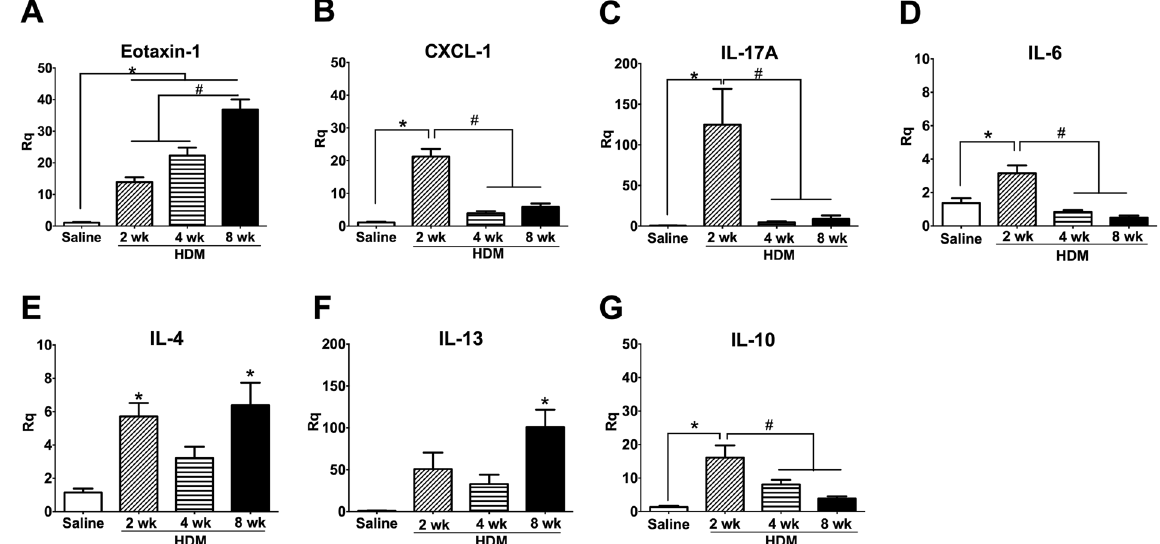
Figure 6. The 3 HDM models exhibit different patterns of inflammatory mediator expression. ( A ) Eotaxin-1 expression increased with increasing duration of HDM sensitization while expression of CXCL-1, IL-17A and IL-6 ( B – D , respectively) was highest at 2 weeks. IL-4 and IL-13 expression ( E , F ) showed a biphasic pattern of expression, with the greatest increases seen in the 8-week model. ( G ) IL-10 expression peaked at 2 weeks with progressively lower expression at 4 and 8 weeks ( * p < 0.05 vs Saline, # p < 0.05 with HDM groups, n = 6/group).